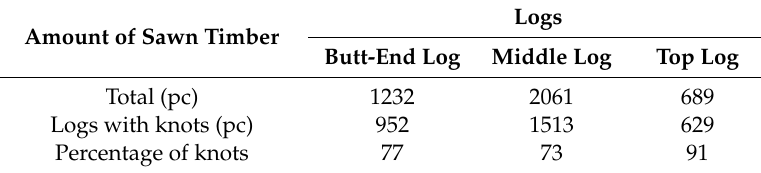
Table 13. The percentage of knots as a factor affecting the quality class of sawn timber in the longitudinal section of long logs.